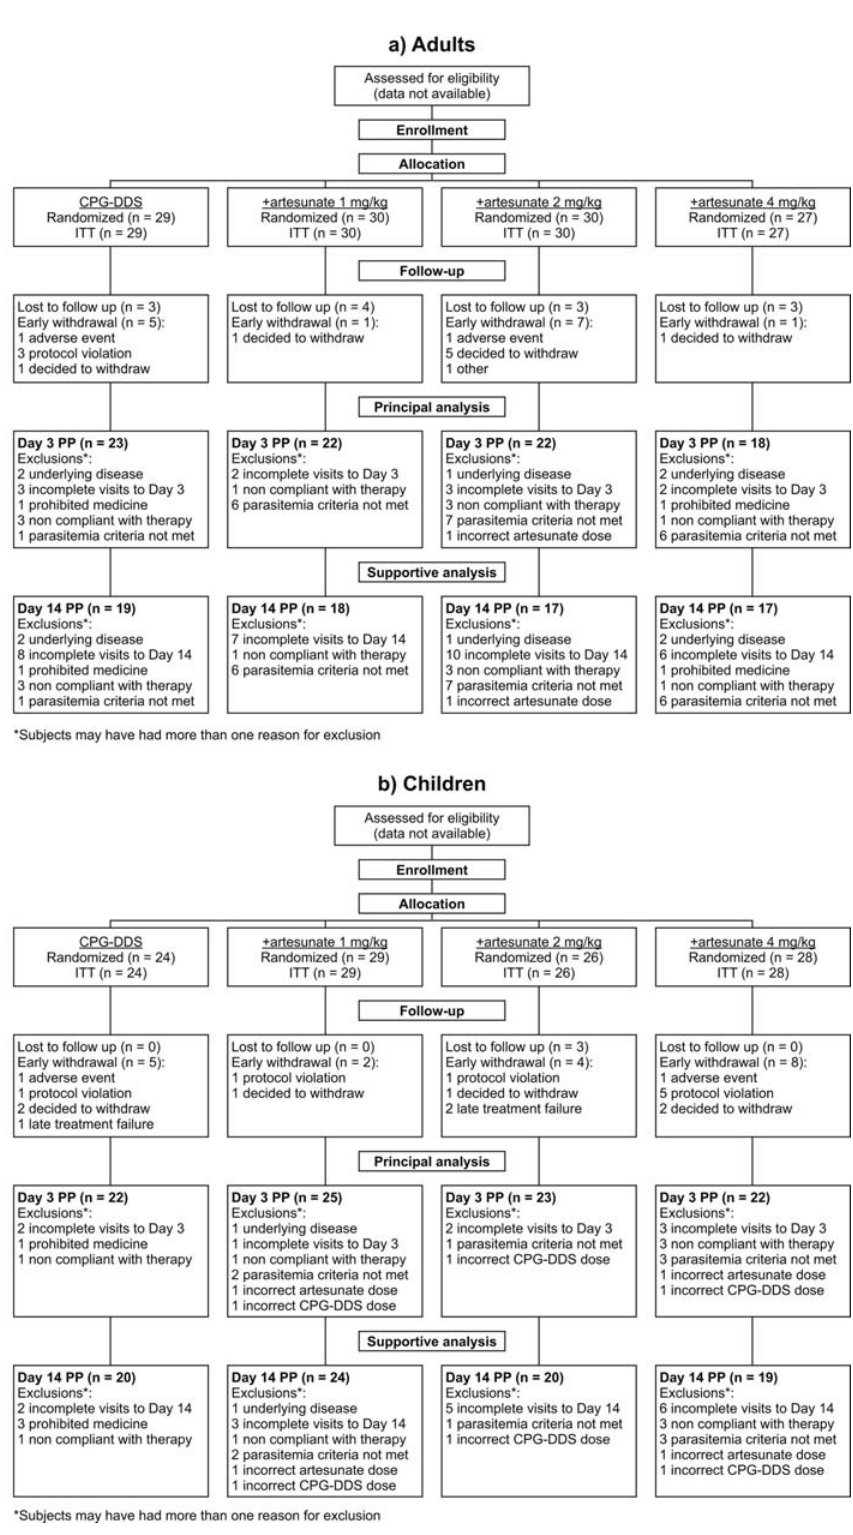
Figure 1. Trial profile of the study and patient flow for a) adults and b) children. ITT=intent to treat population; PP=per-protocol population.